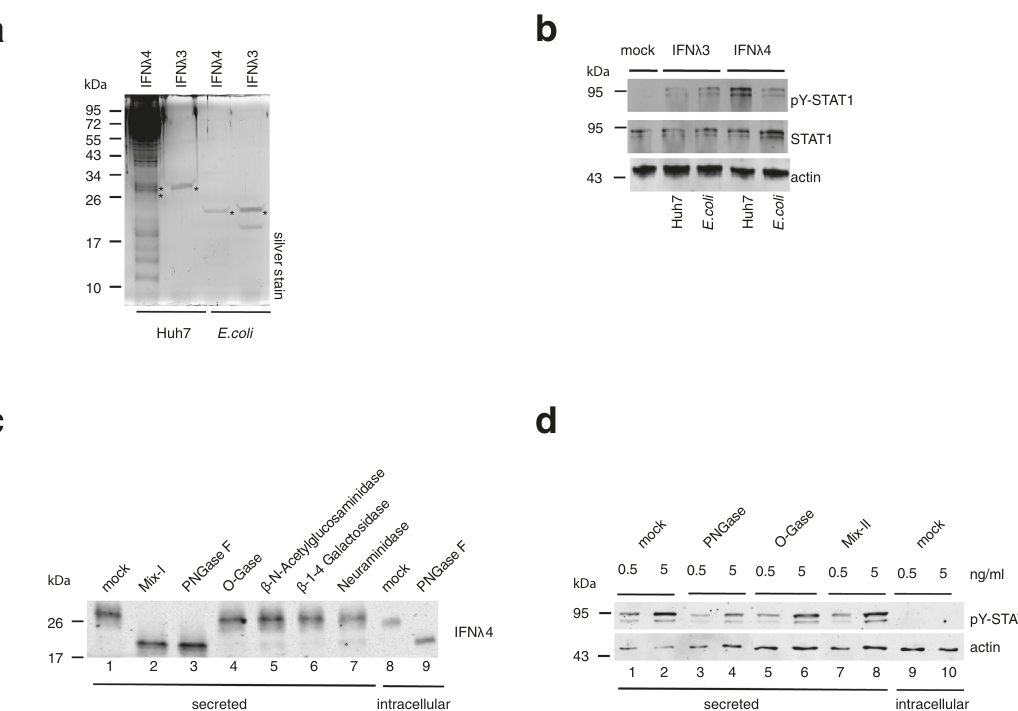
Fig. 3 IFN λ 4 activity is dependent on N-linked glycosylation. a 50 ng each of IFN λ 4 and IFN λ 3 puri fi ed from Huh7 cells or E. coli were analyzed by 12% SDS-PAGE and quanti fi ed by silver staining. IFN λ 4 and IFN λ 3 proteins were indicated by an asterisk (*). Huh7-produced IFN λ 3 and IFN λ 4 proteins are C-terminally tagged with Myc and 6× His, while E. coli -produced IFN λ 3 and IFN λ 4 proteins are N terminally tagged with 6× His. M, protein molecular weight marker; kDa, kilodalton. Data are representative of n = 3 independent experiments. b Huh7-LR cells were stimulated for 30 min with 8 ng/ml of IFN λ 4 or IFN λ 3 puri fi ed from Huh7 cells or E. coli or with supernatants collected 48 h-post mock transfection (mock) in Huh7 cells. Cells were lysed and analyzed for STAT activation by western blotting for pY – STAT1, STAT1, and actin as a loading control. c 10 μ l of puri fi ed IFN λ 4 from Huh7 cell-culture supernatant (secreted) was incubated alone in GlycoBuffer (mock) or was digested with a protein deglycosylation mix (Mix-I, an enzyme mix of PNGase F, O -glycosidase, β - N -acetyl glucosaminidase, β 1 – 4 galactosidase or α 2-3,6,8 neuraminidase), N-linked glycosidase (PNGase F), O-link glycosidase (O-Gase), β - N -acetylglucosminidase, β -1 – 4 galactosidase or neuraminidase at for 1 h 37 °C. A cell lysate of IFN λ 4-transfected-Huh7 cells was incubated in GlycoBuffer (mock) or digested with PNGase F for 1 h at 37 °C. IFN λ 4 proteins in the digested samples were detected by IFN λ 4-speci fi c western blotting. kDa, kilodalton. d Puri fi ed IFN λ 4 (secreted) and a cell lysate of IFN λ 4-transfected-Huh7 cells (intracellular) were mock-treated in GlycoBuffer or treated exactly as described in ( c ) with the indicated glycosidases (PNGase F, O-Gase and Mix-II, an enzyme mix of β - N -acetylglucosminidase, β -1 – 4 galactosidase, neuraminidase). Huh7-LR cells were stimulated for 30 min at 37 °C with the mock-treated or glycosidase-digested IFN λ 4 preparations at 0.5 and 5 ng/ml. Stimulated cells were processed and analyzed as described in ( b ). Data are representative of n = 3 independent experiments in ( b – d ). Source data are provided as a Source Data fi